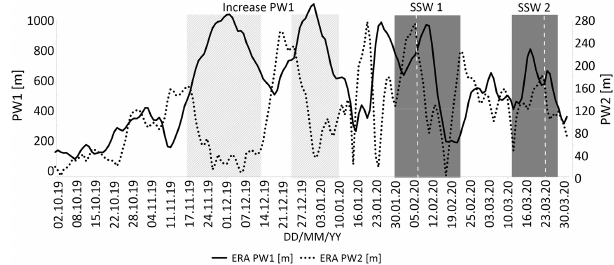
Figure 12. Same as Fig. 3 but October 2019 through March 2020.